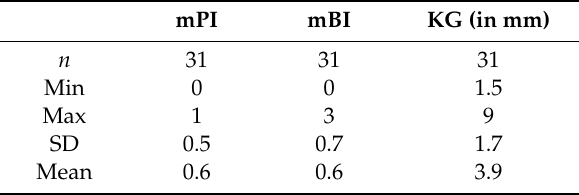
Table 8. Peri-implant soft tissue